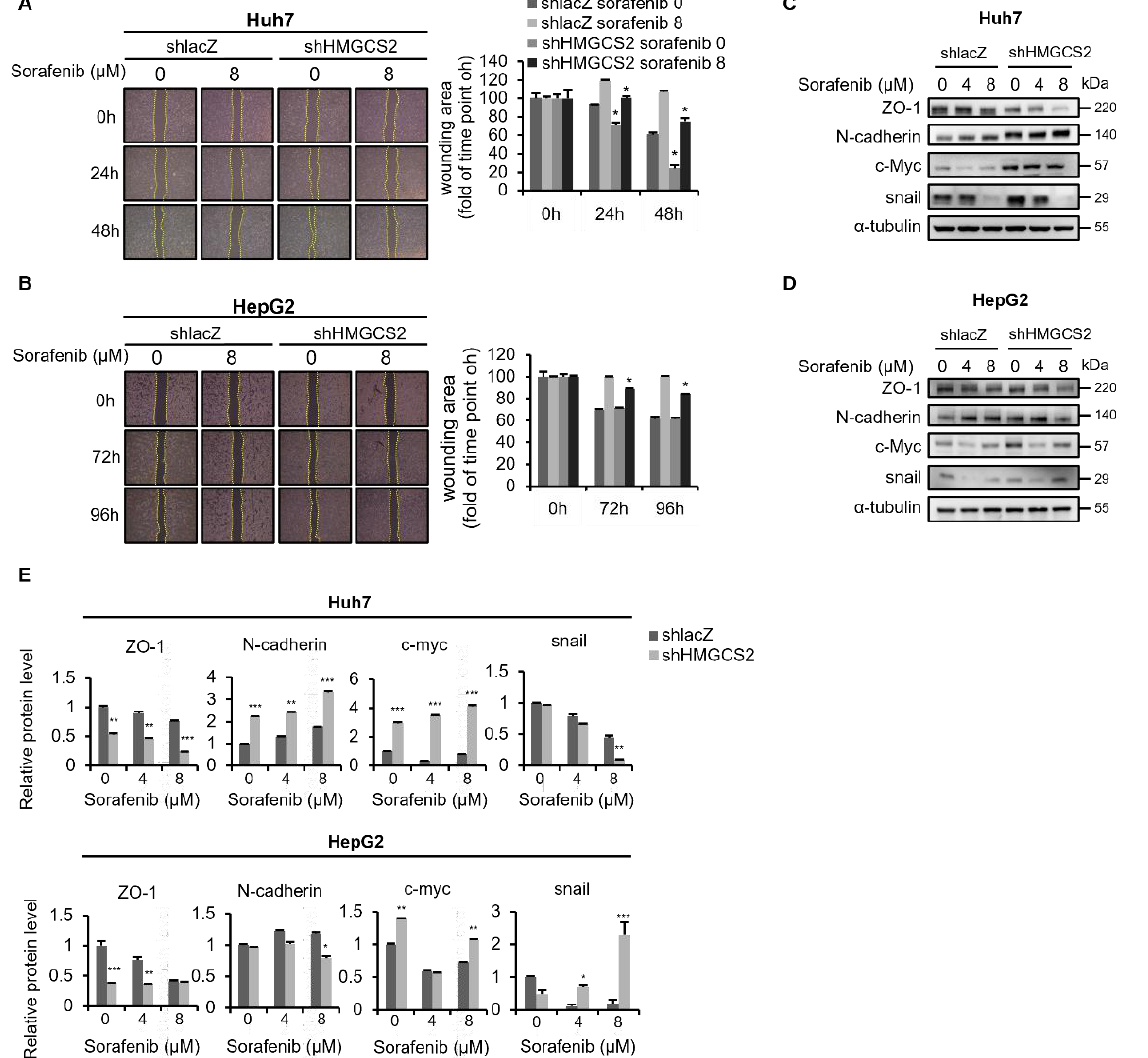
Figure 3. HMGCS2-knockdown enhanced the migratory ability and epithelial-mesenchymal transition of sorafenib-treated Huh7 and HepG2 cells. ( A , B ) HMGCS2-knockdown HCC cells (4.3 × 10 5 cells/well of Huh7 cells and 10 6 cells/well of HepG2 cells) were seeded in ibidi culture inserts and treated with 0 and 8 μM sorafenib. Images were collected at the indicated time point, and the wound-healing areas were measured with ImageJ software. ( C , D ) shlacZ control and shHMGCS2 Huh7 and HepG2 cells were treated with sorafenib at concentration of 0, 4, and 8 μM for 48 h. Protein expression levels of zonula occludens (ZO)-1, N-cadherin, c-Myc, and Snail were evaluated by Western blotting. α -Tubulin was used as a loading control. The representative data are obtained from three independent experiments. ( E ) Western blot images from Figure 3C,D, quantified by ImageJ software. * p < 0.05; ** p < 0.01; *** p < 0.001 vs. the shlacZ control. Data are shown as the mean ±